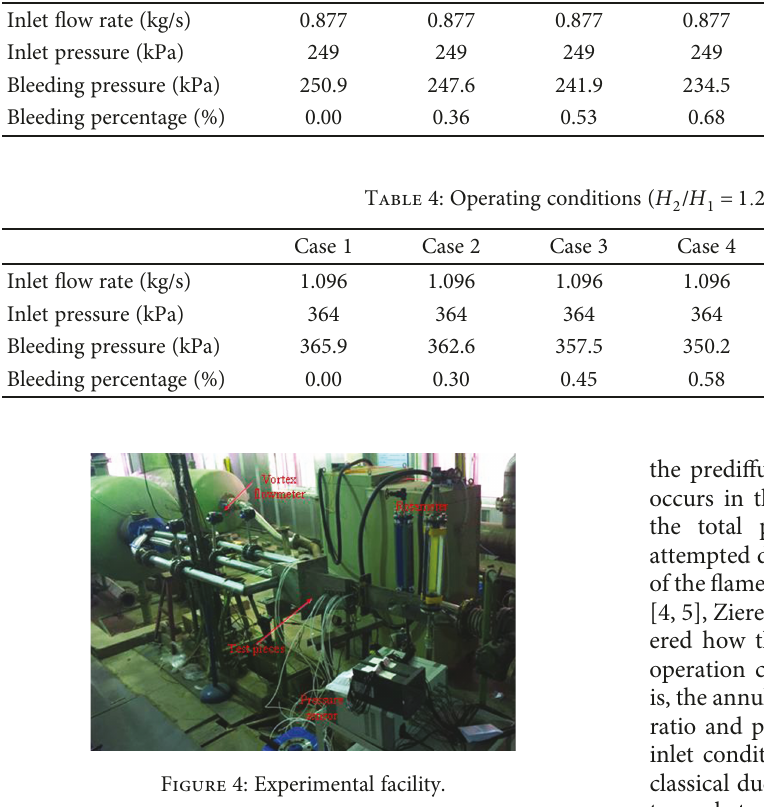
/ H = 1 20, T = 30 ° C ). 2 1